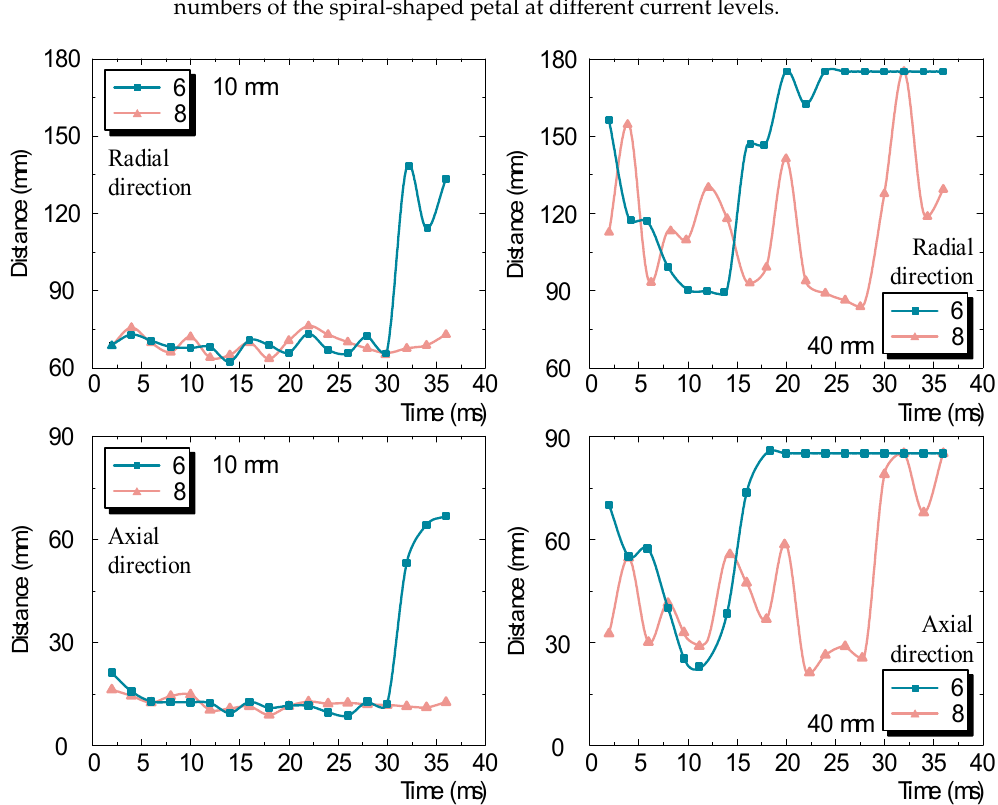
Figure 16. A comparison of arc diffusion under different electrode structure design with different numbers of the spiral-shaped petal at different gap distances.